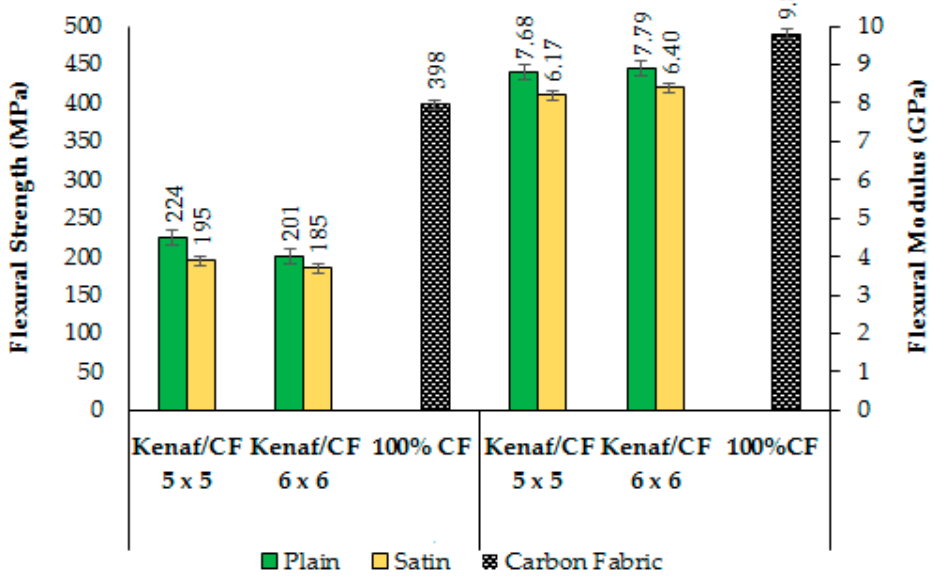
Figure 8. Flexural strength and flexural modulus of woven kenaf/carbon fibre hybrid composite.